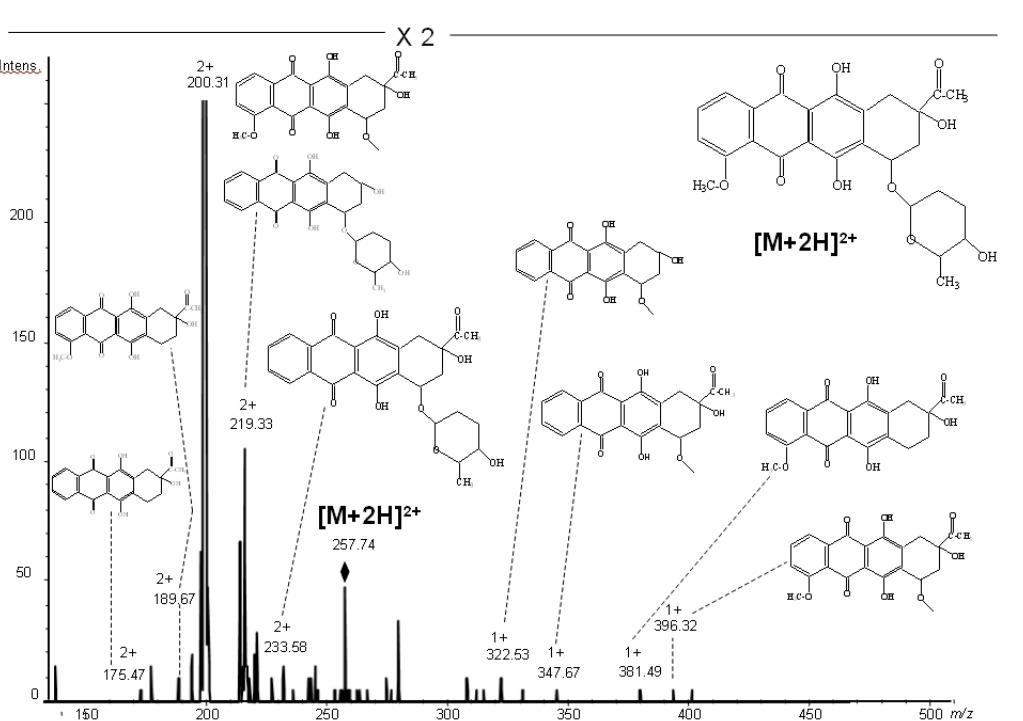
Figure 5. NanoMate-ETD/CID MS 3 of the [M+2H + ] 2+ ion detected at m/z 257.74 in ETD MS 2 of Dau-GnRH III [M+3H + ] 3+ ion. Acquisition time 20 s. Inset: the structure of Dau moiety and of Dau-derived fragment